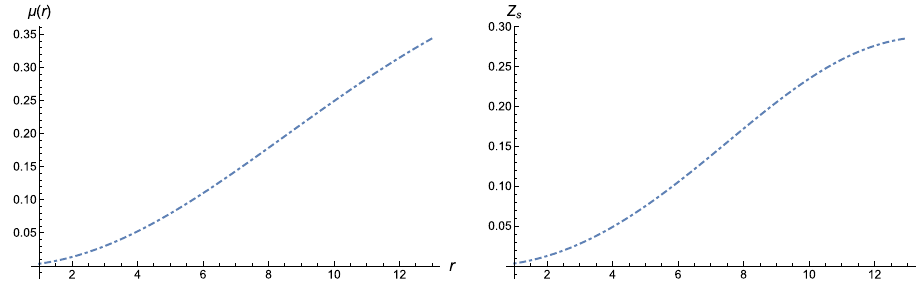
Fig. 12 Plots of the compactness μ( r ) and surface redshift ( Z s ) of the strange star candidate Her X-1 with respect to the radial coordinate r (km)